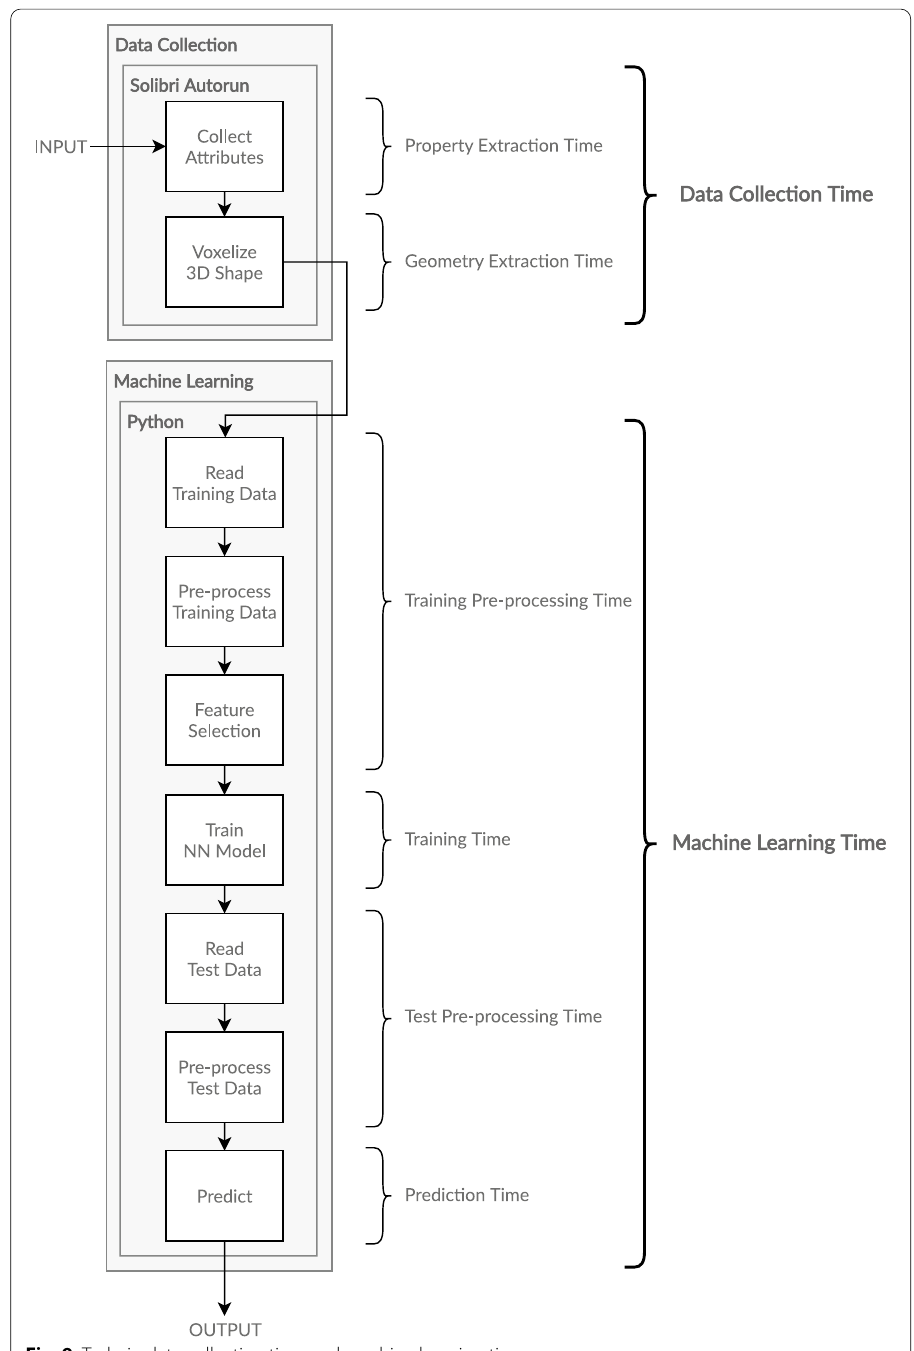
Fig. 9 Tasks in data collection time and machine learning